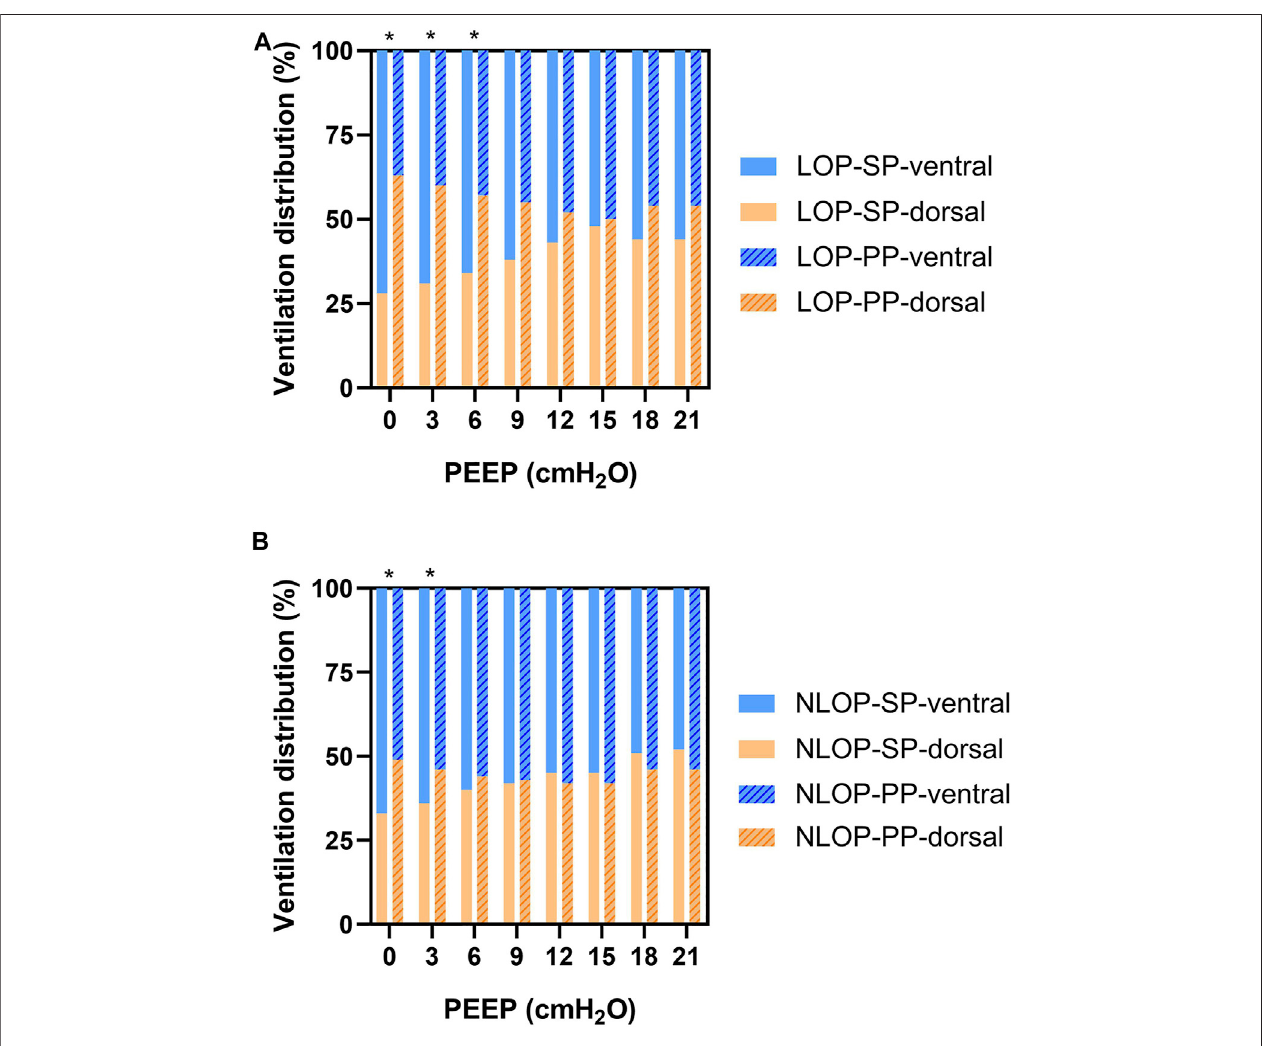
FIGURE 3 | Dorsal ventilation was signi fi cantly higher during prone position at lower PEEP in the LOP group (PEEP = 0, 3, 6 cmH 2 O) (A) . The signi fi cant improvement of dorsal ventilation was also present at PEEP of 0 and 3 cmH 2 O in the NLOP group (B) . * p < 0.05 compared with supine position.